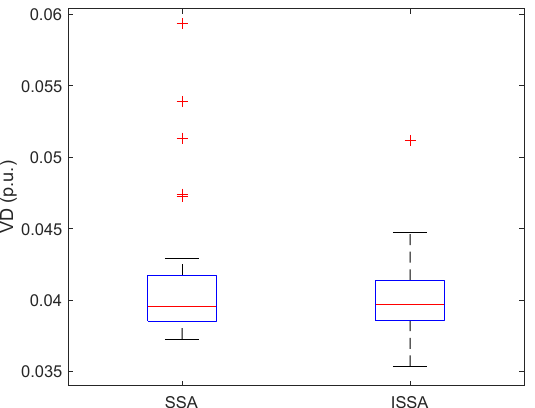
Figure 4. Boxplots of SSA and ISSA for VD minimization for IEEE 14-bus system.